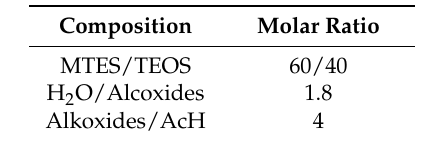
Table 3. Composition of the 60MTES/40TEOS